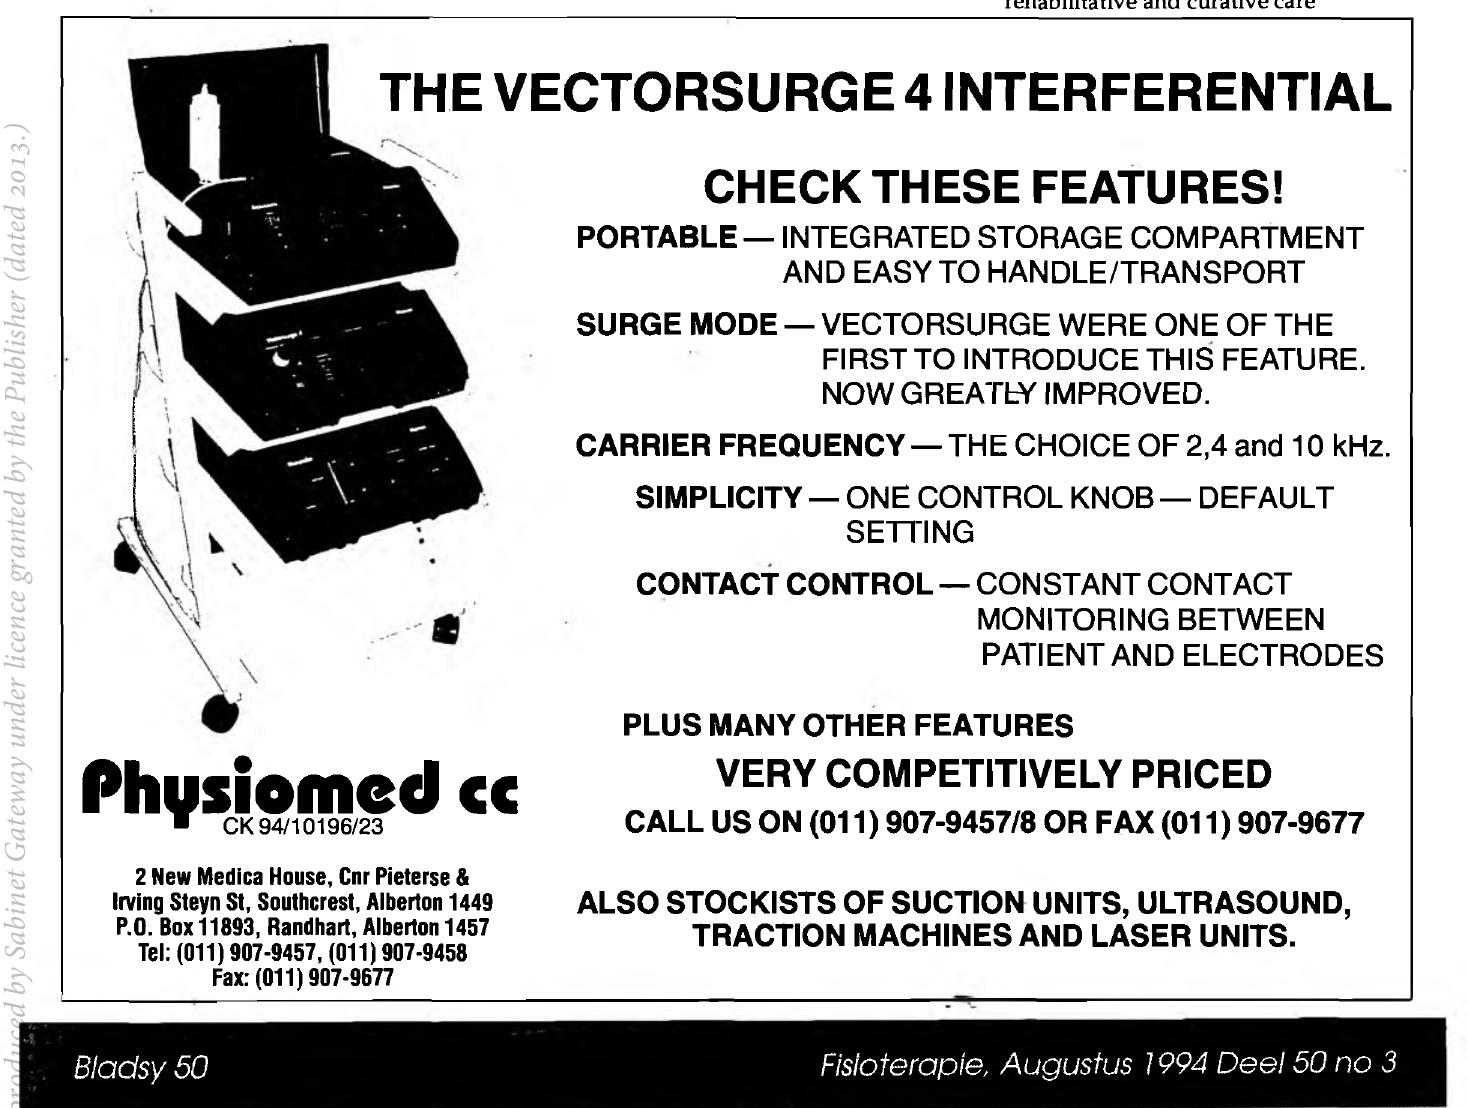
THE V EC T O R SU R G E 4 INTERFERENTIAL CHECK THESE FEATURES! PORTABLE — INTEGRATED STORAGE